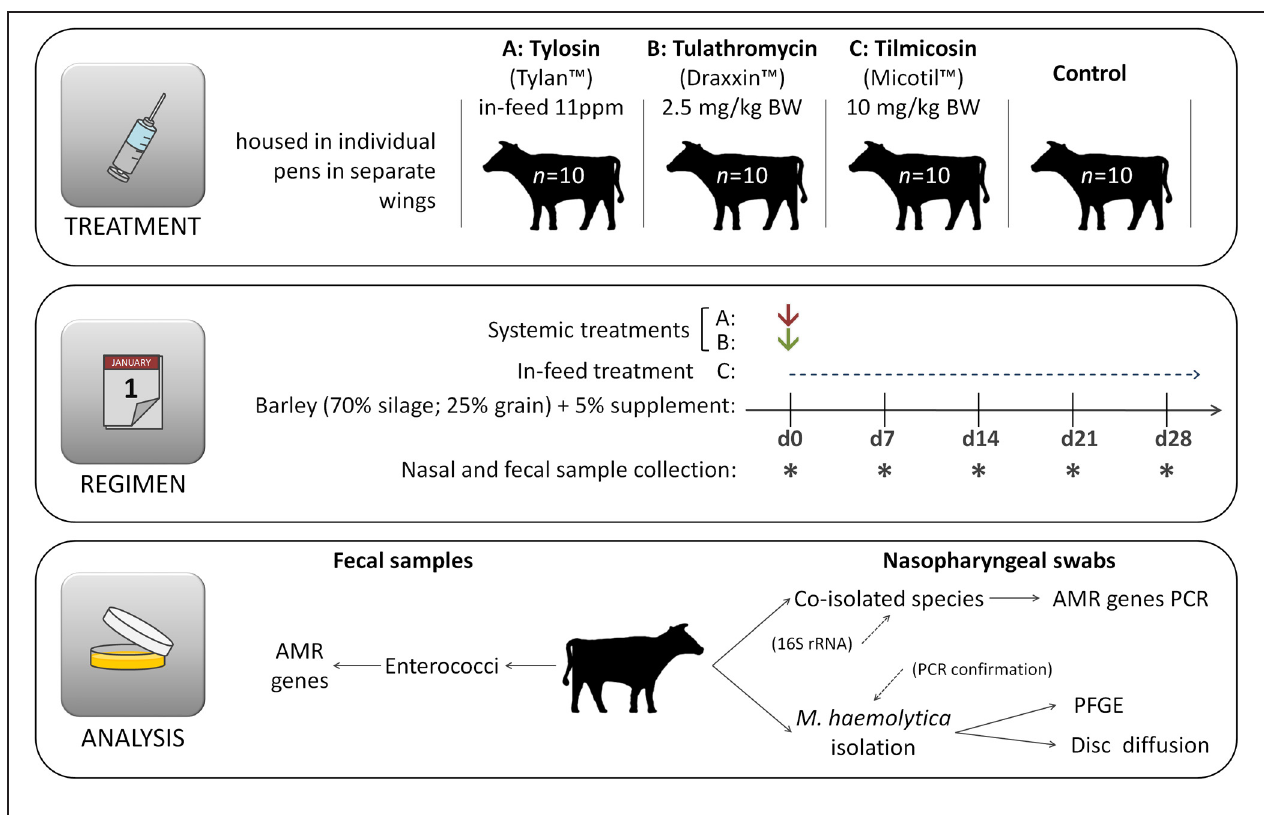
FIGURE 1 | Experimental design. Immediately after first sample collection on day 0 (d0) animals were administered appropriate treatments and hence the same day is also referred as day 1,